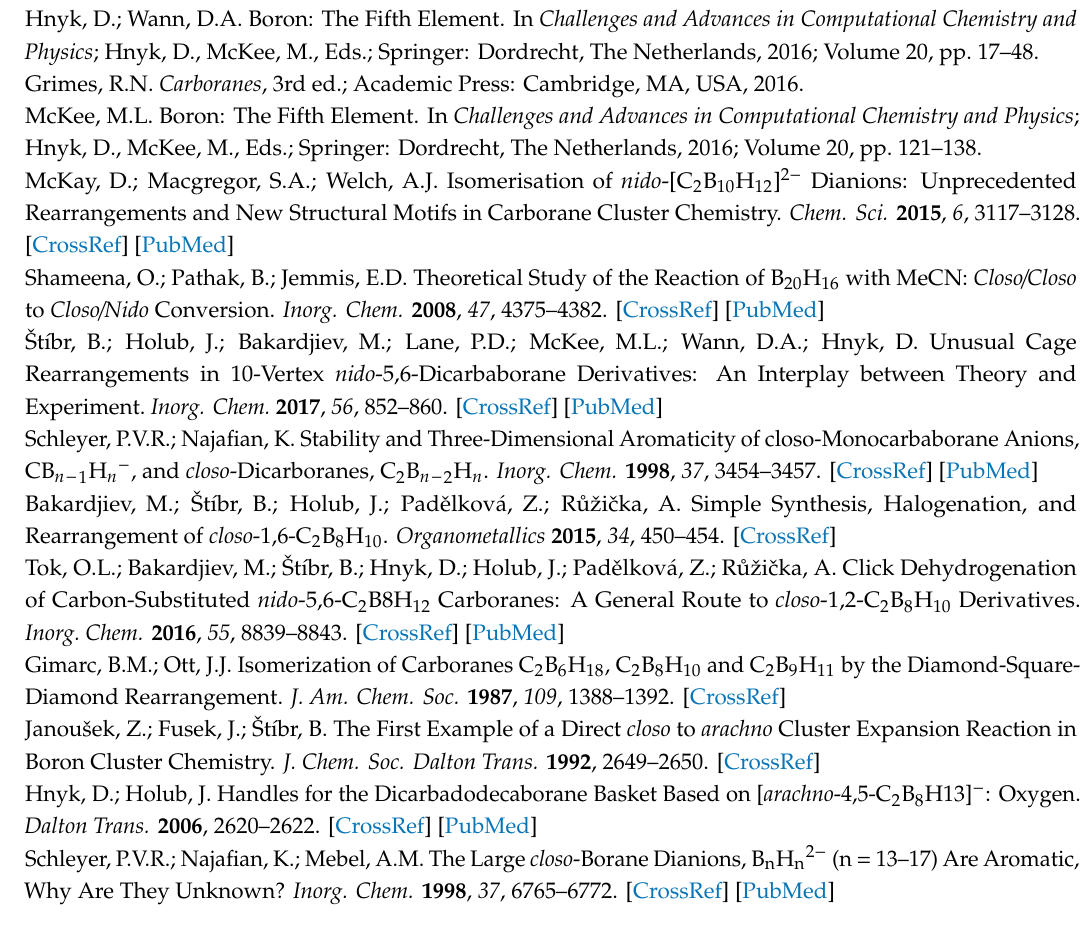
Figure S1: Individual stationary points as detected in the reaction pathway of the reaction of closo -1,6-C 2 B 8 H 10 with OH ( − ) , Figure S2: Relative free energies (kcal · mol − 1 ) of the individual stationary points on the PES of the reaction of closo -1,6-C 2 B 8 H 10 with OH ( − ) , Figure S3: Individual stationary points as detected in the reaction pathway of the reaction of closo -1,10-C 2 B 8 H 10 with OH ( − ) , Figure S4: Relative free energies (kcal · mol − 1 ) of the individual stationary points on the PES of the reaction of closo -1,10-C 2 B 8 H 10 with OH ( − ) , Figure S5: Individual stationary points as detected in the reaction pathway of the reaction of closo -1,6-C 2 B 8 H 10 with NH 3 , Figure S6: Relative free energies (kcal · mol − 1 ) of the individual stationary points on the PES of the reaction of closo -1,6-C 2 B 8 H 10 with NH 3 , Figure S7: Individual stationary points as detected in the reaction pathway of the reaction of 1,10-C 2 B 8 H 10 with NH 3 , Figure S8: Relative free energies (kcal · mol − 1 ) of the individual stationary points on the PES of the reaction of closo -1,10-C 2 B 8 H 10 with NH 3 , Table S1: Number of imaginary frequencies, zero-point energies (kcal · mol − 1 ), heat capacity correction (kcal · mol − 1 ), entropies (cal.mol − 1 · K − 1 ), solvation free energies (kcal · mol − 1 ), and free energies relative to the appropriate reference. Small o, m, or p refer to ortho (1,2-), meta (1,6-), or para (1,10-)C 2 B 8 H 10 , respectively. Capital letters “A”, “B”, “C”, etc. or “TS#” are related to individual intermediates or transition states, respectively. If there were two conformations possible, two letters are used to discern them (e.g., oG / G (cid:48) -O, oK / K (cid:48) -O, or oM / M (cid:48) -O). Capital “-O” or “-N” distinguish between the reactions of OH(-) or NH3, respectively. In cases where the intermediate is relatively stable (and already isolated or possibly trappable), “P1”, “P2”, “P3”, etc. is used instead of “A”, “B”, “C”. Table S2: Cartesian coordinates of all species in Table